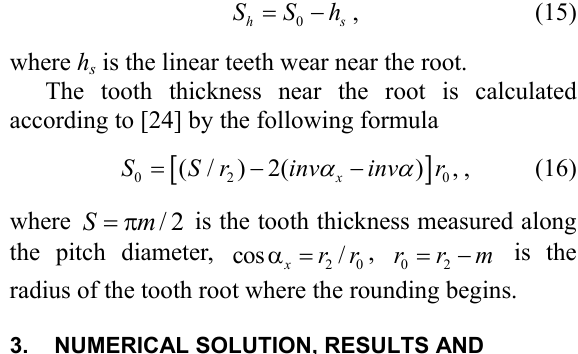
Fig. 2 shows the relative durability t (cid:4) of MM and MP gear trains at change of the friction